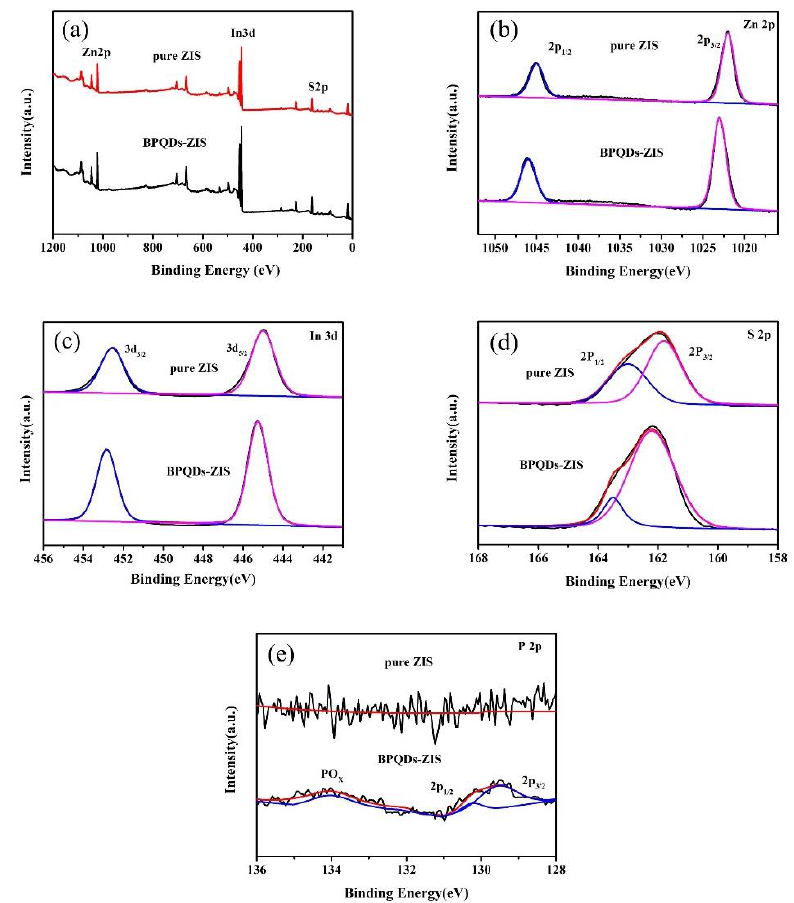
Figure 3. Full survey scanned X-ray photoelectron spectroscopy (XPS) spectra of ZnIn 2 S 4 and BPQD–ZIS ( a ); Zn 2 p ( b ), In 3 d ( c ), S 2 p ( d ), and P 2 p ( e ) high-resolution XPS spectra of ZnIn 2 S 4 and BPQD– ZIS.